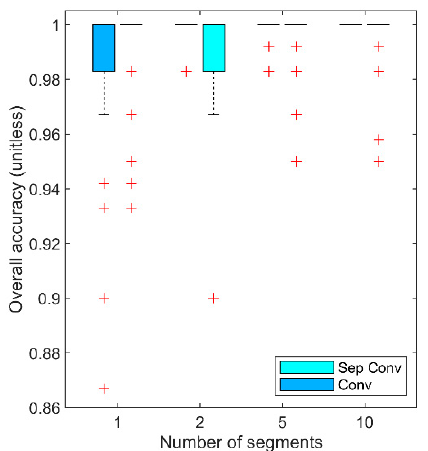
Figure 5. Transfer learning results. Six to sixty segments (1 to 10 per subject, x -axis) were drawn randomly from the training set and used to fine-tune CNNs. The overall classification accuracy ( y -axis) was then computed for 60 segments drawn randomly from the test set. Fifty trials per segment number were finally repeated (total: 200 trials). Boxplots (quartiles and median) are shown. “ + ” signs indicate outliers. Note that the boxplots are collapsed because most of the trials reached 100% accuracy.